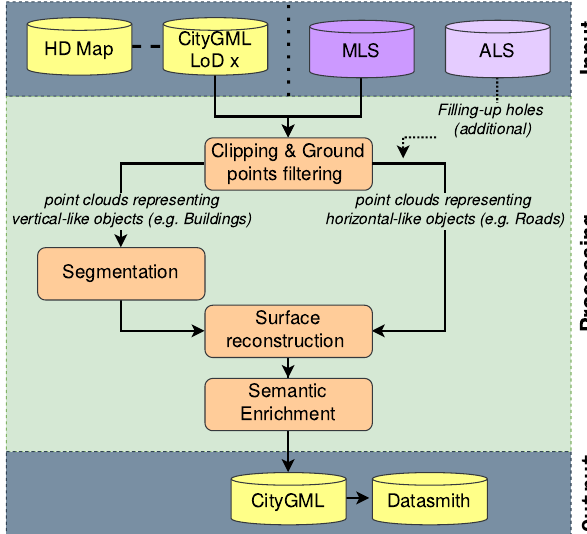
Figure 2. Methodology overview: Unstructured datasets marked with purple while structured datasets with yellow hue and the action boxes have orange